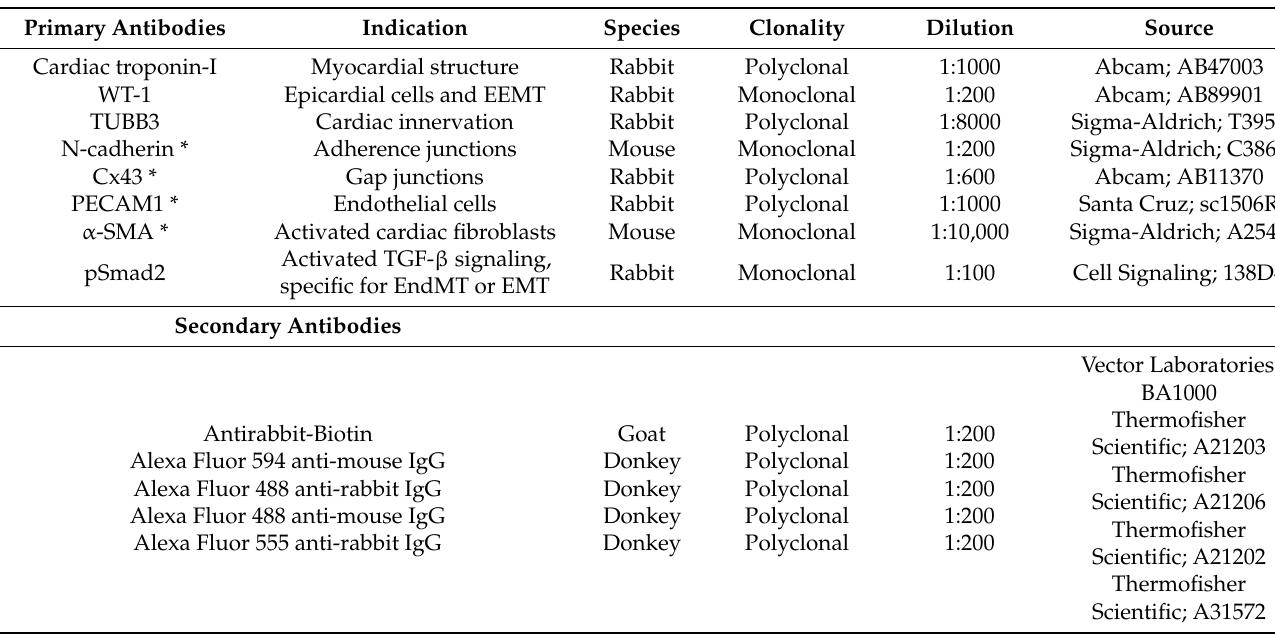
Table 1. List of antibodies used for immunohistochemical and immunofluorescence